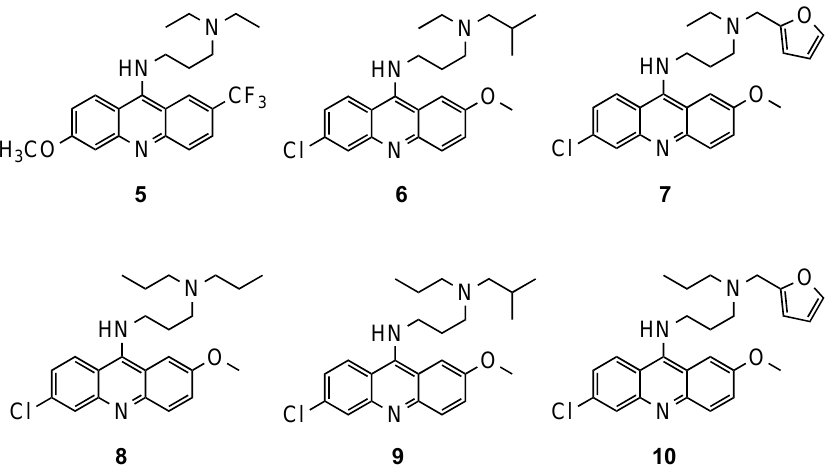
Figure 5. Best compounds ( 5 – 10 ) developed by Anderson and co-workers [15].